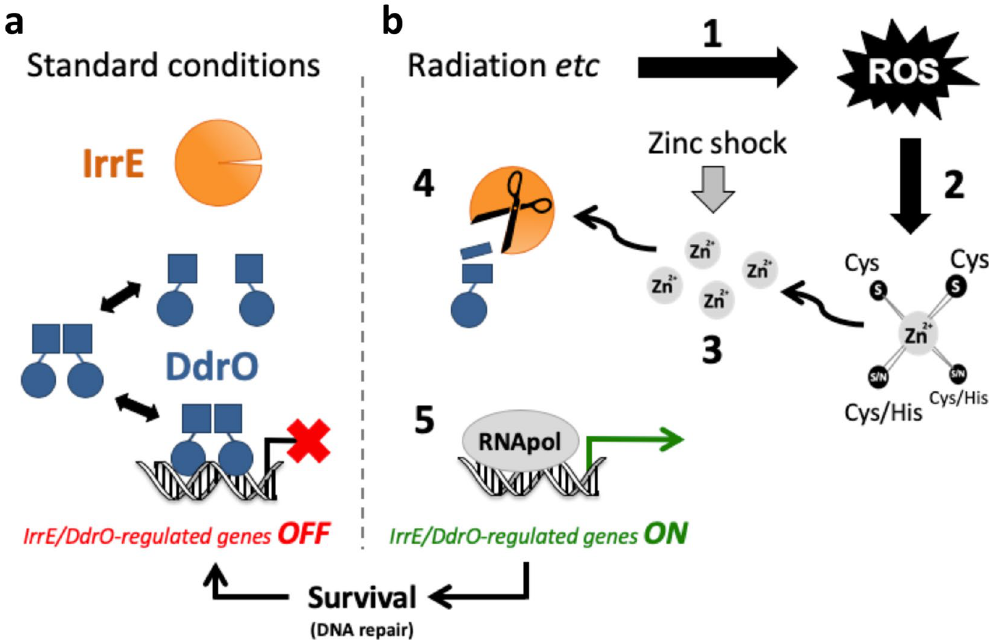
Figure 6. Proposed model of the IrrE/DdrO-controlled stress response mechanism. ( a ) Under standard conditions, repressor DdrO exist as a dynamic equilibrium between monomers and free and DNA-bound dimers. DdrO dimerization is mediated by its C-terminal domain. Binding of DdrO dimer to a conserved target DNA motif located in the promoter region of IrrE/DdrO-regulated genes represses their transcription. The majority of metalloprotease IrrE is inactive. ( b ) Exposure to conditions such as radiation generates oxidative stress through formation of ROS (step 1), which can cause oxidation of cysteine residues of zinc/cysteine sites in proteins (step 2), concomitantly causing release of zinc ions from these sites and a transient increase in the intracellular concentration of free, available zinc ions (step 3). The released zinc functions as second messenger, and increases the amount of active zinc-bound IrrE that cleaves the C-terminal domain of monomeric DdrO (step 4) abolishing its dimerization and shifting the DdrO equilibrium toward cleavable monomers. The diminished amount of DdrO leads to induced expression of the IrrE/DdrO-regulated genes (including several DNA repair genes and ddrO itself) (step 5). A zinc shock directly augments the intracellular free zinc ion concentration. Figure based on data obtained here and previously 14,17,19